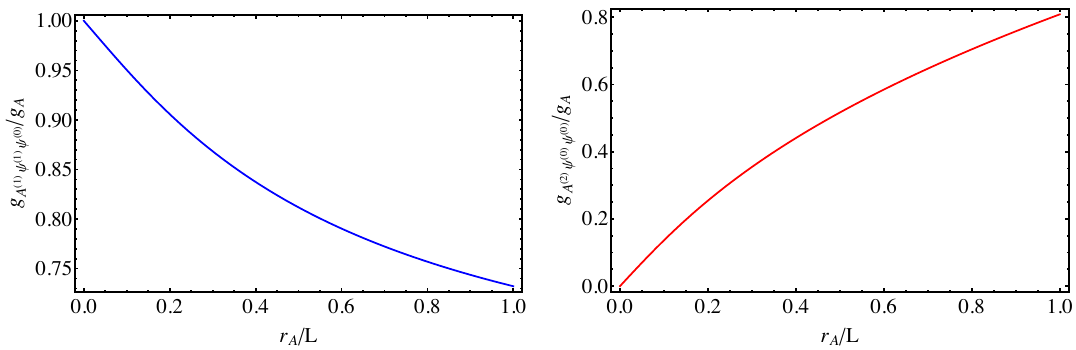
Figure 3 . Couplings of KK gauge bosons to fermions, normalized with respect to the Standard Model gauge couplings, as a function of the boundary parameter r A . Left: the KK number conserving coupling of a U(1) Y or SU(2) (cid:12)rst KK mode gauge boson to a (cid:12)rst KK mode fermion and a Standard Model fermion ( ~ F A as de(cid:12)ned in eq. (2.26)). Right: the KK number violating 110 interaction of a U(1) Y or SU(2) second KK mode gauge boson to Standard Model fermions ( ~ F A 200 as de(cid:12)ned in eq.